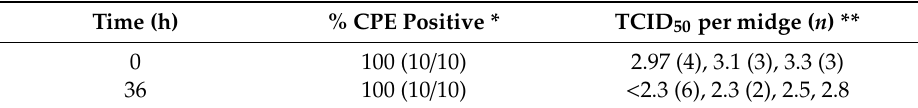
Table 1. Virus isolation from EHDV-infected